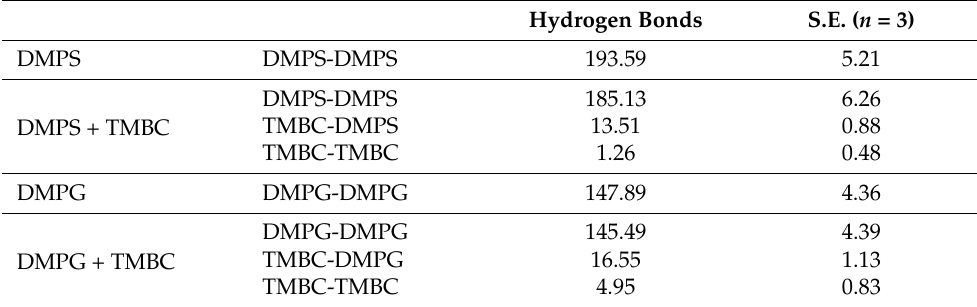
Table 1. Hydrogen bonds of the phospholipid polar headgroups and TMBC. The dimyristoylphos- phatidylserine (DMPS) data presented were obtained from previously reported simulations